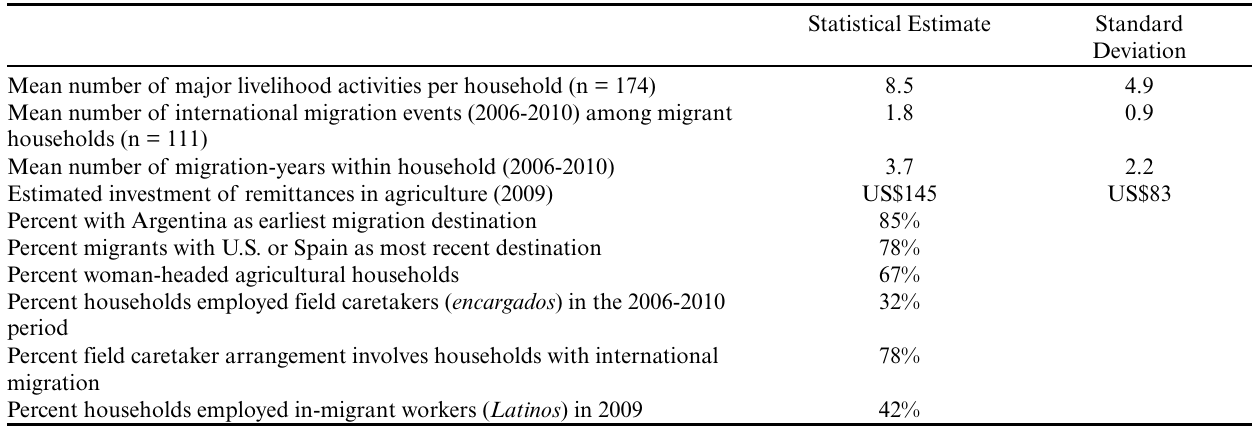
Table 5 . Livelihood characteristics of migrants, field caretakers, and in-migrant